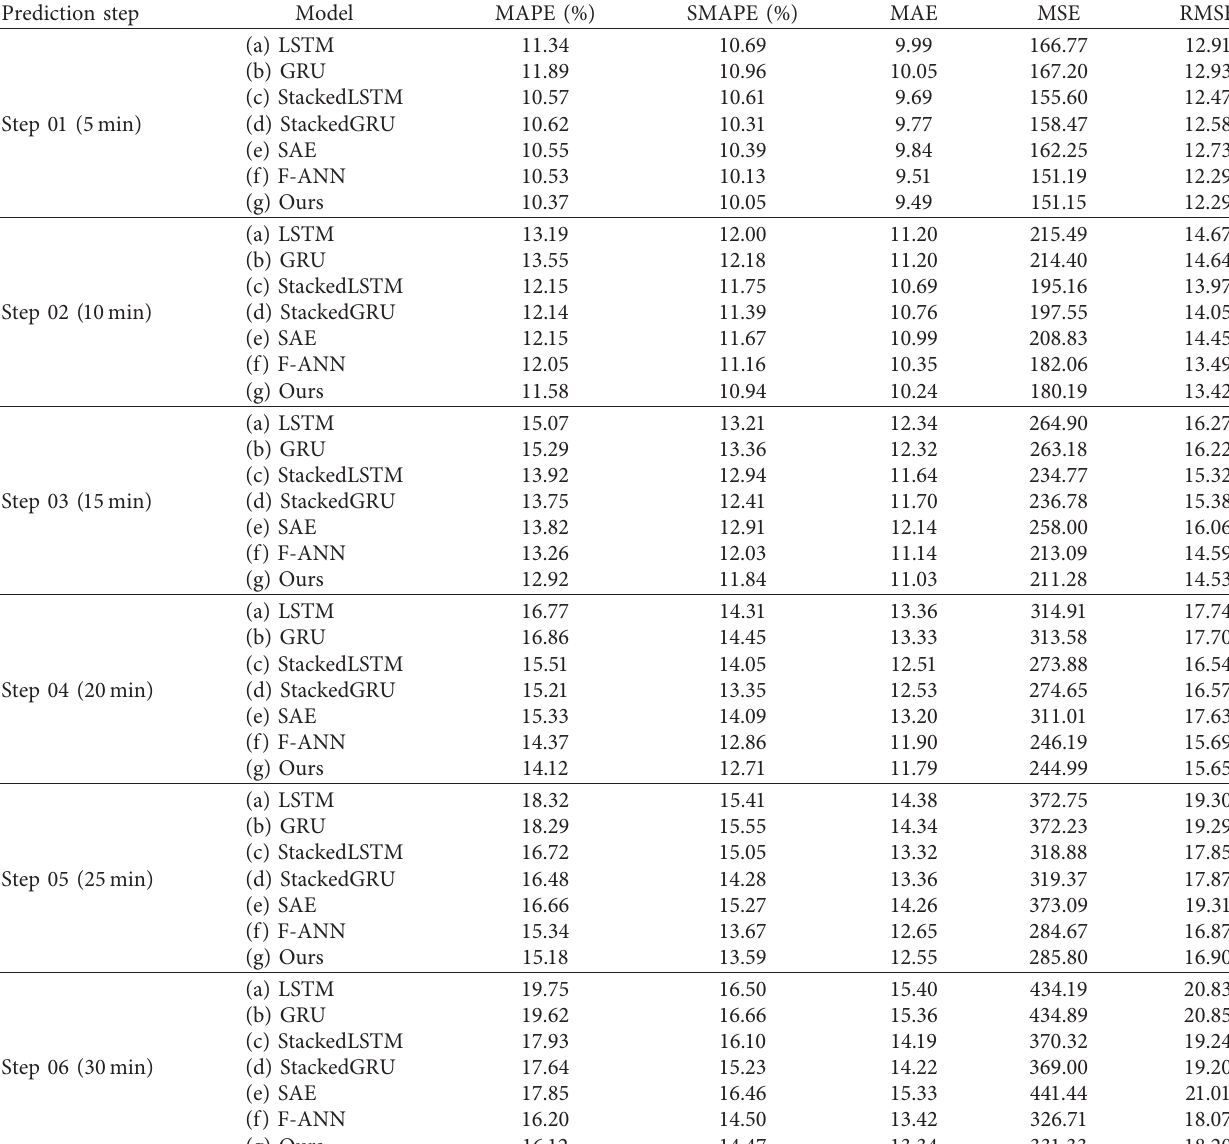
Table 6: Performance comparison in multiple